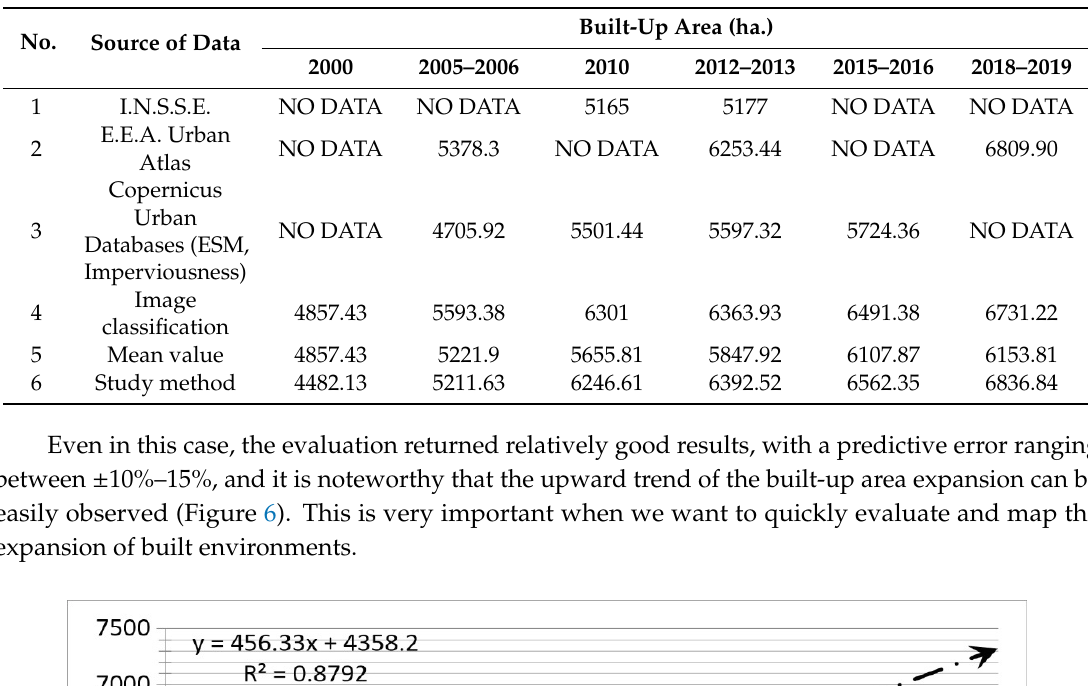
Table 5. Accuracy assessment and validation by method number 3.